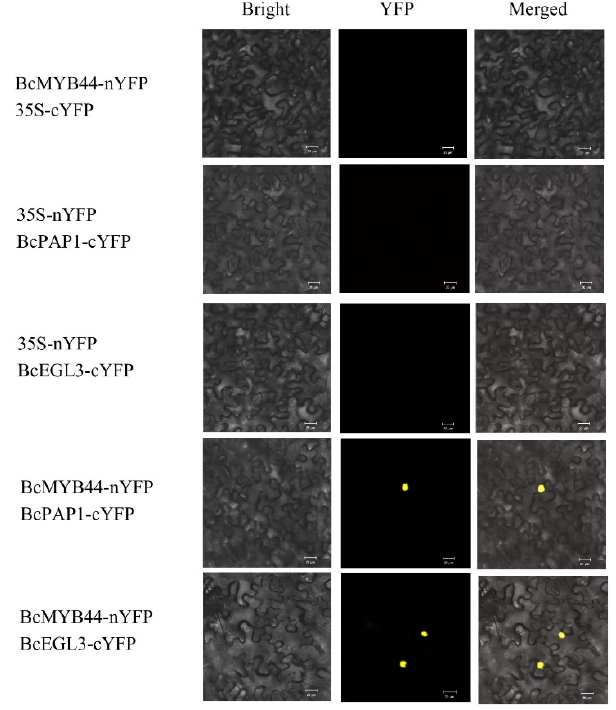
Figure 4. BiFC verification of BcMYB44 and BcPAP1, BcEGL3. Bright: Bright field; GFP: green fluorescence signal under GFP-excited light; Merged: superposition of GFP and bright field.BcMYB44- nYFP + 35S-cYFP, 35S-nYFP + BcPAP1-cYFP and 35S-nYFP + BcEGL3-cYFP were the control group. Scale bars = 20 µ